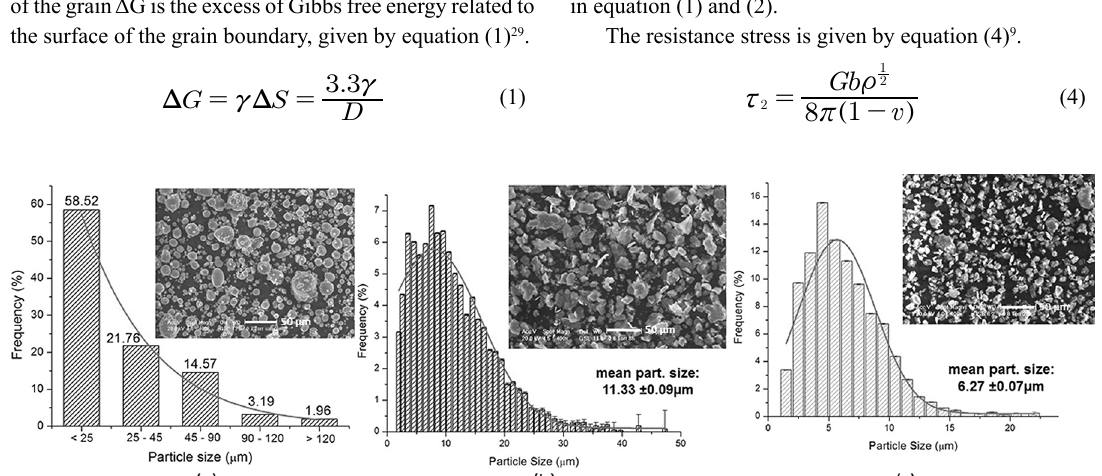
Figure 2. Size distribution and SEM images of the powders (a) as-received atomized powder, and powders milled for (b) 8 h and (c) 25